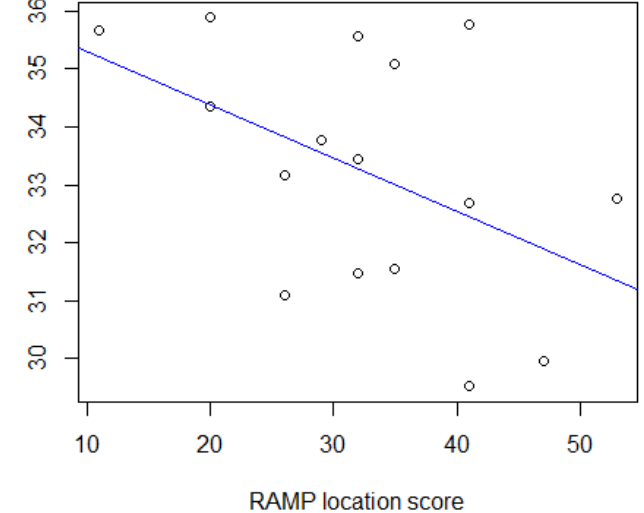
Figure 2. Scatterplot to illustrate the correlation between the lowest Ct value for a location and the RAMP score for the location.